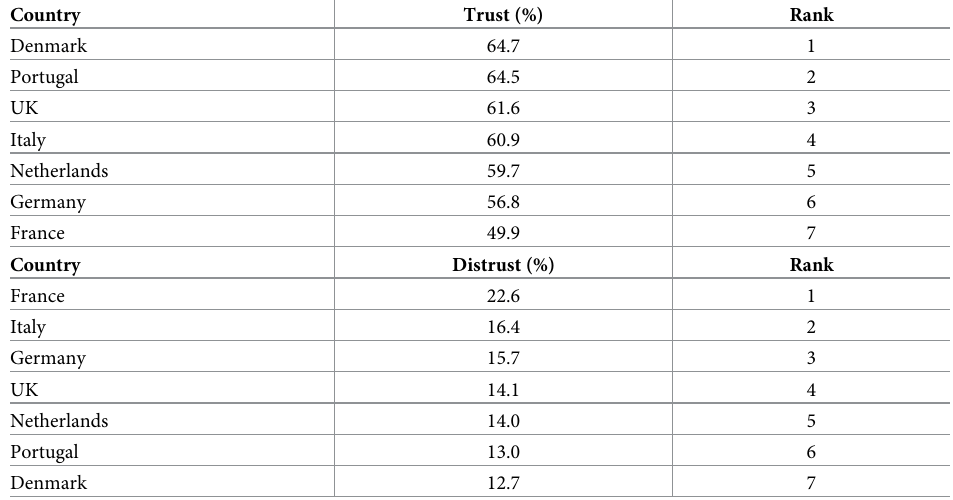
Table 3. Relative ranking of countries according to the proportion of respondents who trust and distrust informa- tion from the WHO. Country